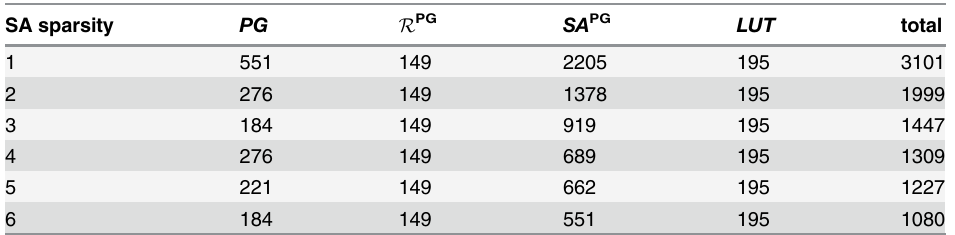
Table 3. E. coli dataset, space consumption. All sizes in